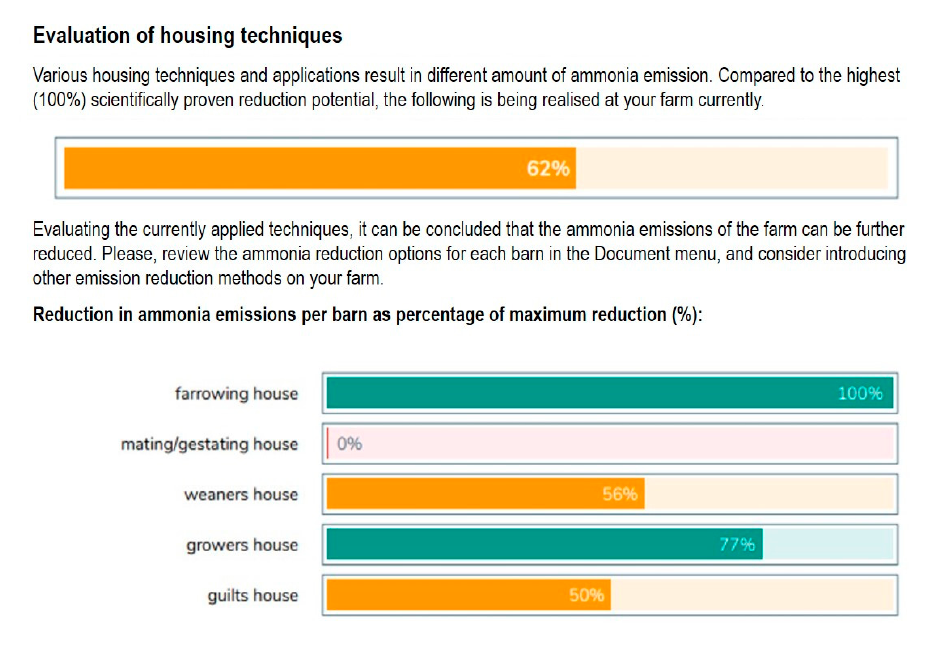
Figure 3. Evaluation of housing techniques in AGEM-S (example).